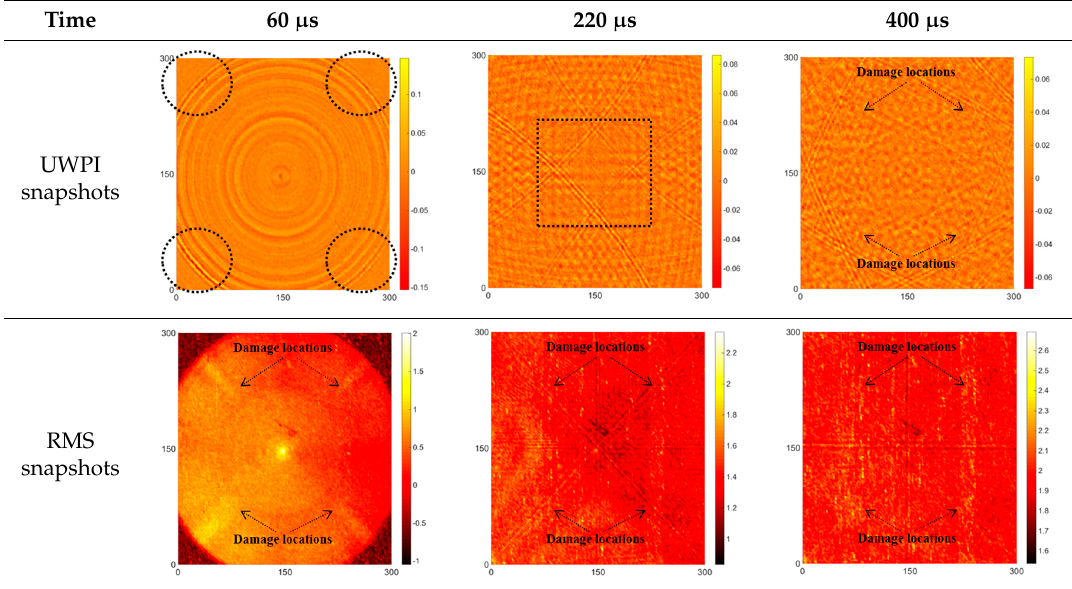
Table 8. UWPI and RMS snapshots of the front side of Specimen 2 at 60 µ s, 220 µ s and 400 µ s (the unit of x and y axis: mm).